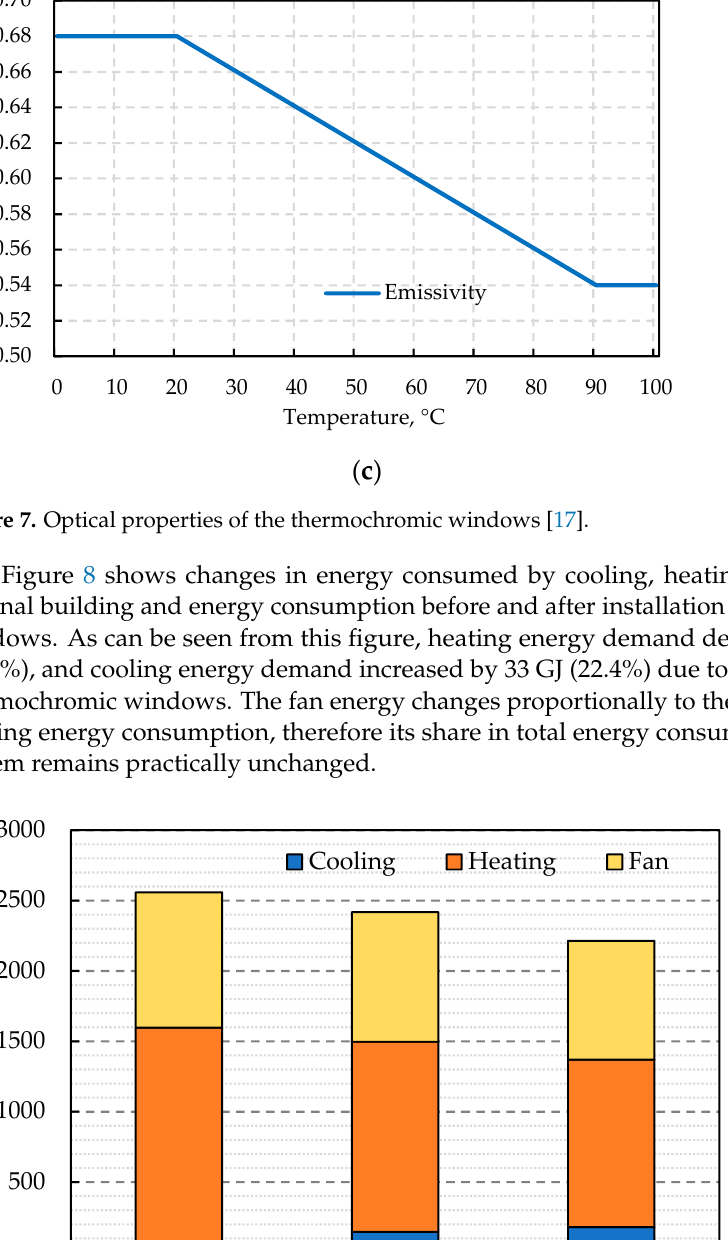
Figure 8. Energy consumption of the hotel in its original design and before and after installation of thermochromic windows.